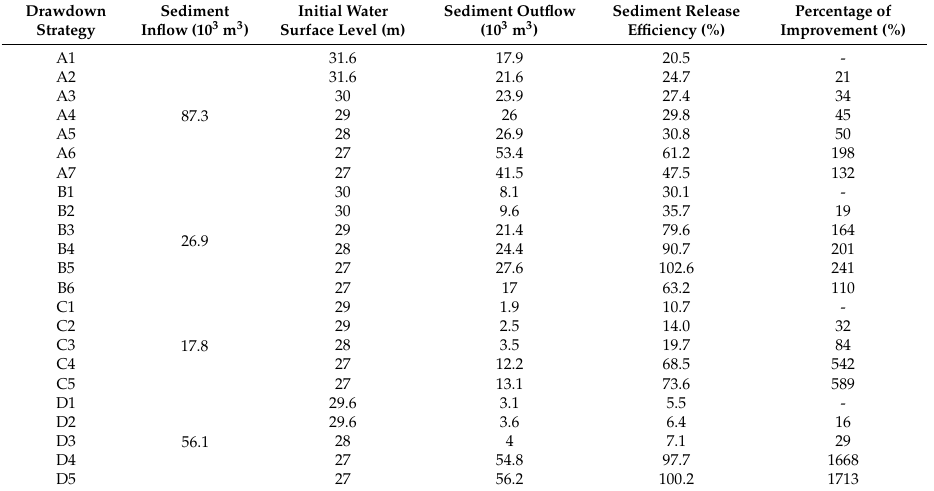
Figure 9. Different velocities based on numerical simulations using baseline conditions (A1) of Typhoon Fanapi compared to different types of scenarios, including partition desilting with the initial water level at 31 m (A2) and at 28 m (A5). Table 3. Sediment release e ffi ciency rates of each reservoir drawdown strategy. Note, A1, B1, C1, and D1 are observed values, while all other drawdown strategies are the results of numerical